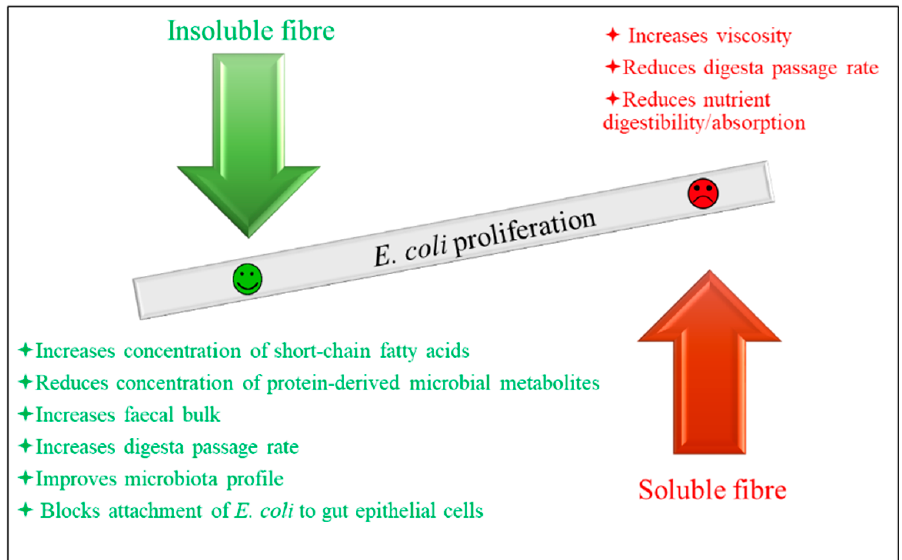
Figure 1. Proposed mode of action behind the effect of insoluble and soluble fibre on E. coli growth in the gut of weaners.